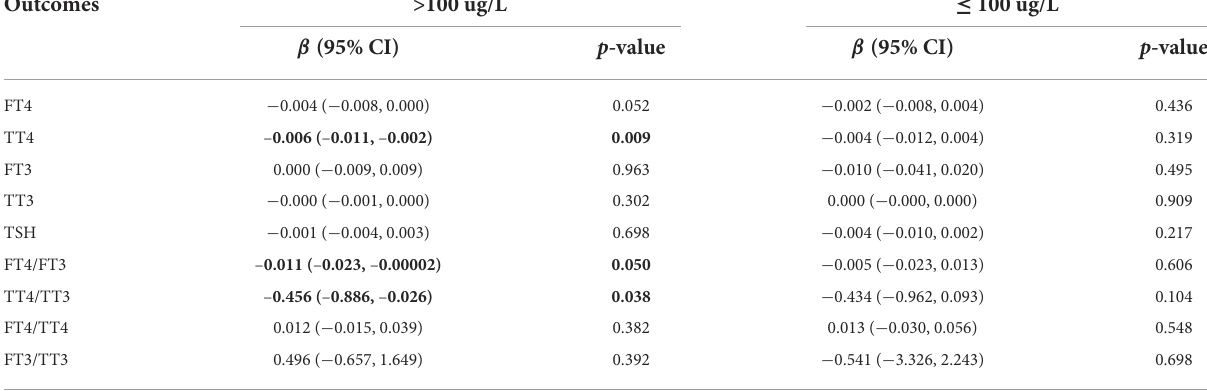
TABLE 4 Association between dietary selenium intake and thyroid hormones in U.S. adults after subgroup analysis by urine iodine